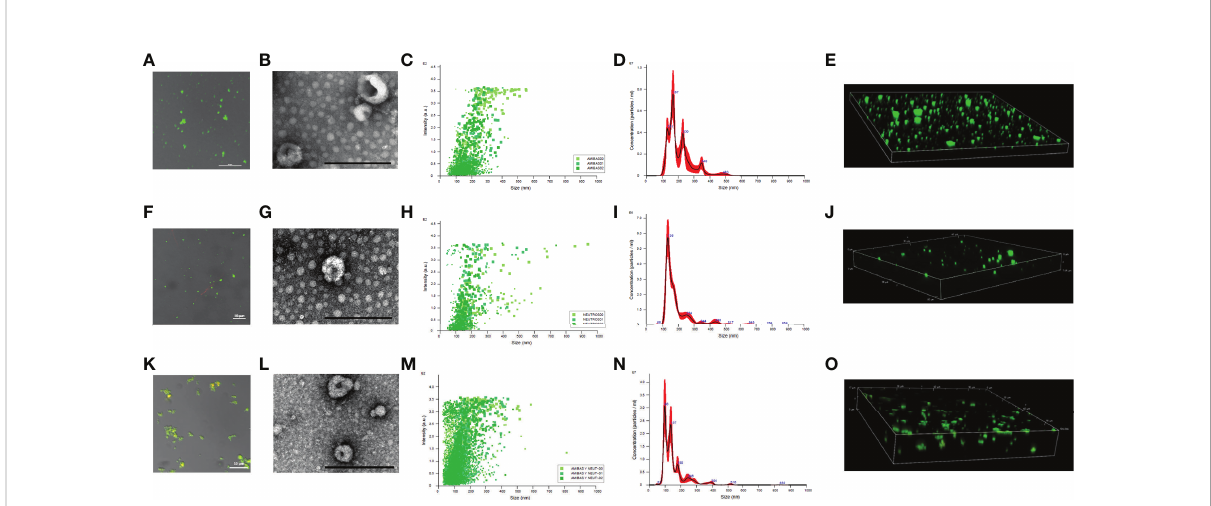
FIGURE 1 Size determination of EVs derived from E. histolytica trophozoites, neutrophils and coculture. EVs from amoebae (A) , neutrophils (F) and cells in coculture (K) were isolated from culture media and stained using DiO (1:10 dilution). EVs were place in 1.5% low melting point agarose for visualization. Scale bar sizes are indicated in each micrograph. TEM of EVs isolated from amoebae (B) , neutrophils (G) and coculture (L) ; scale bar represents 200 nm. EVs size was determine with Nanosight NS3000 for triplicates. It is showed dot plots and histograms for EVs from amoebae (C, D) , neutrophils (H, I) , and coculture (M, N) , respectively. 3D reconstruction of the DiO-stained EVs from amoebae (E) , neutrophils (J) and coculture (O) was obtained through confocal